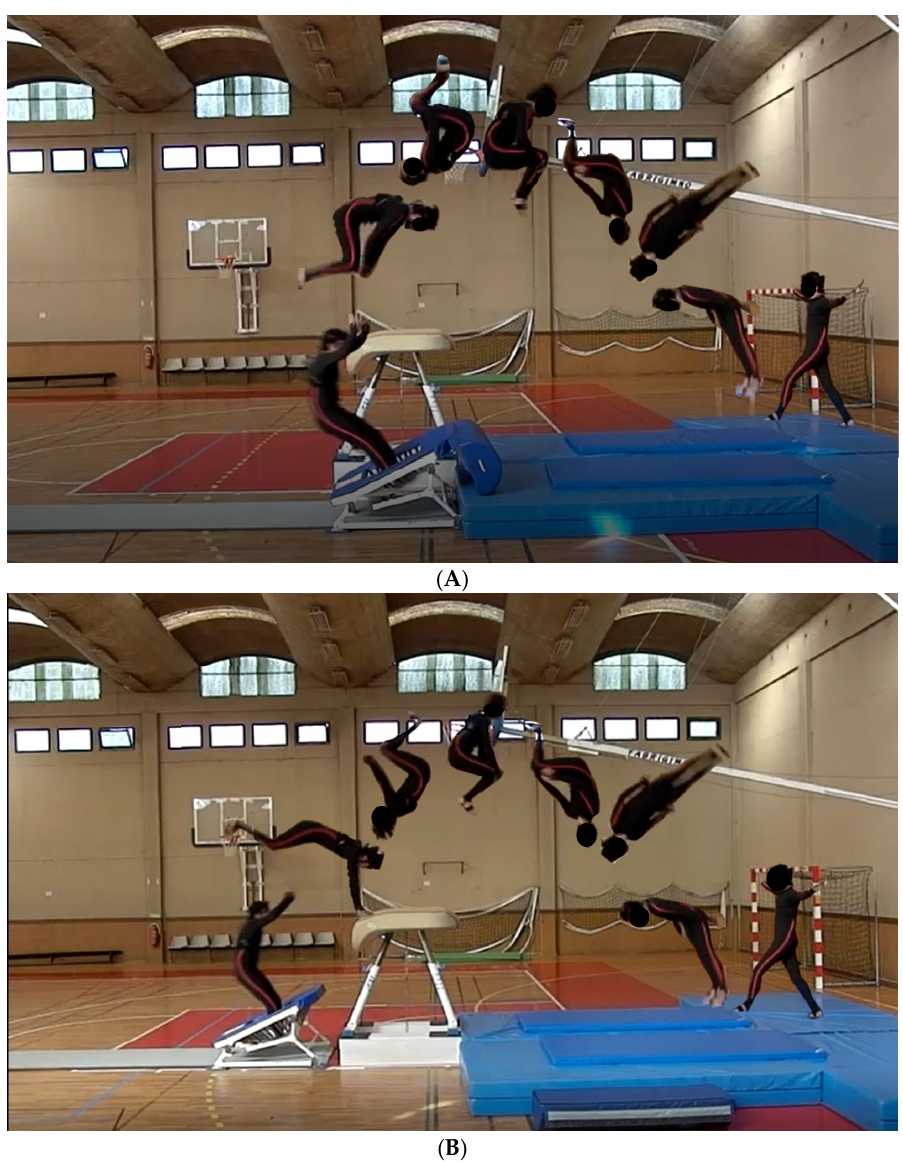
Figure 1. ( A ) Task performed on mini-trampoline (MT): tucked barani out. After a maximum 25 m approach run, the gymnast performs a take-off from the mini-trampoline followed by a double somersault in a tucked position (720 ◦ on transversal axis rotation), and a half twist (180 ◦ on longitudinal axis rotation) before landing. ( B ) Task performed on mini-trampoline with vaulting table (MTVT): handspring tucked barani out. After a maximum 25 m approach run, the gymnast performs a take-off from the mini-trampoline followed by a forward entrance placing their hands in vaulting table (support phase), one and a half somersault in a tucked position (total of 720 ◦ on transversal axis rotation) and a half twist (180 ◦ on longitudinal axis rotation) before